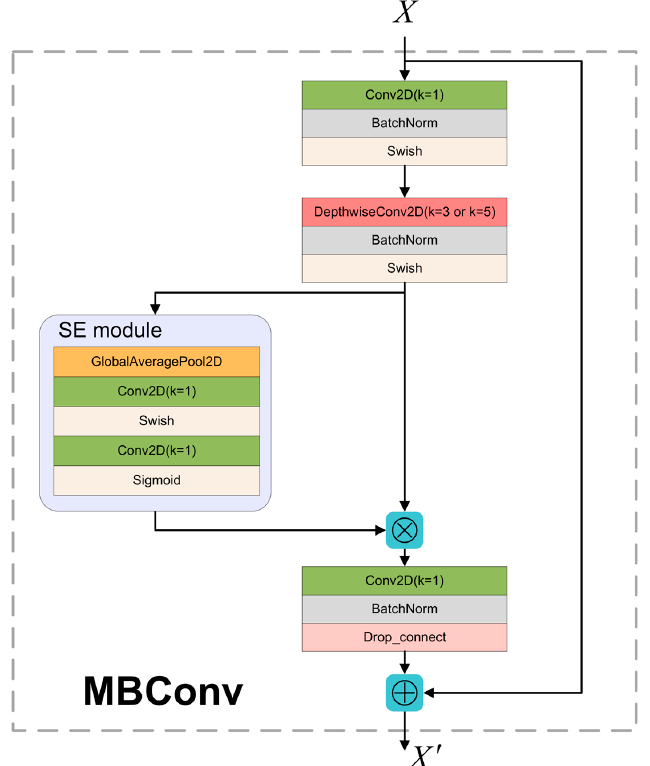
Figure 2. MBConv